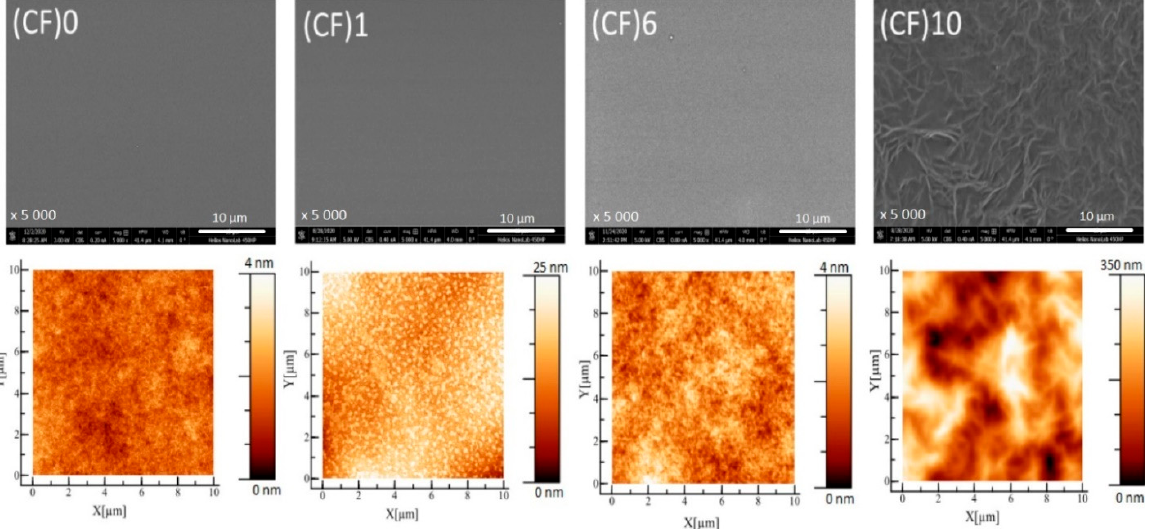
Figure 2. Samples’ topography imaged using SEM (top) and 2D AFM with the height scale (bottom).